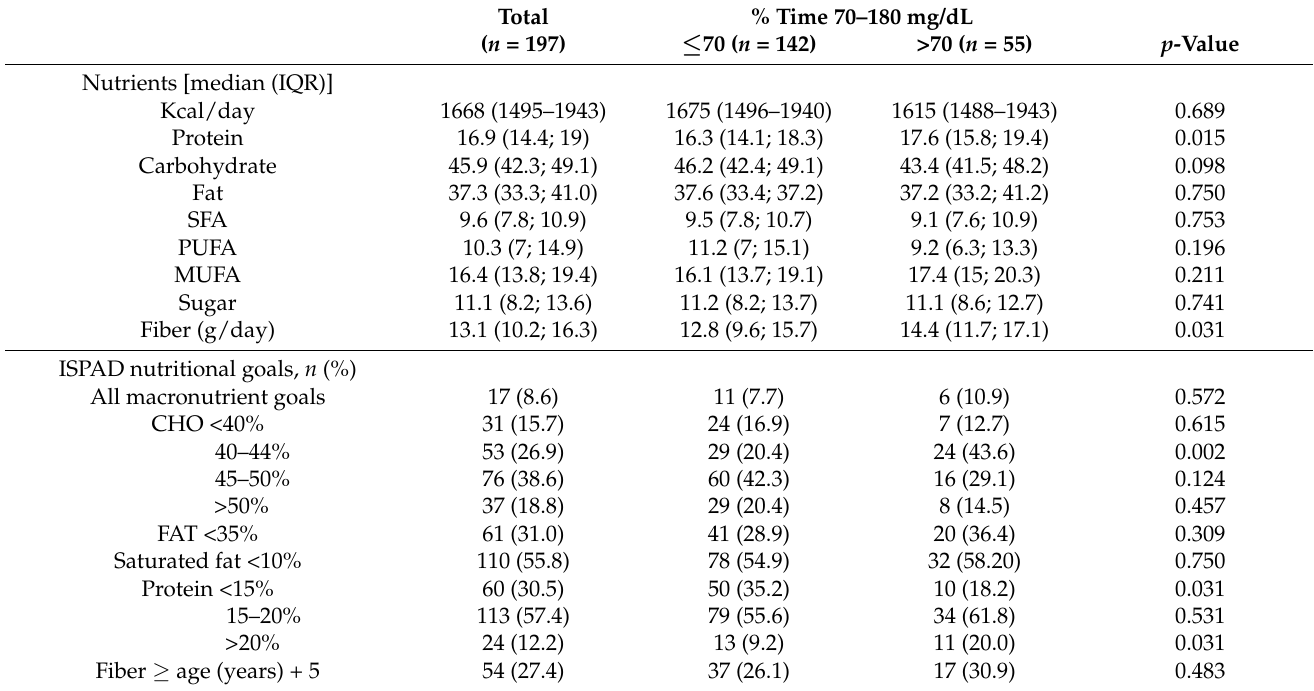
Table 2. Subjects’ nutritional profiles according to percentage of time in range.